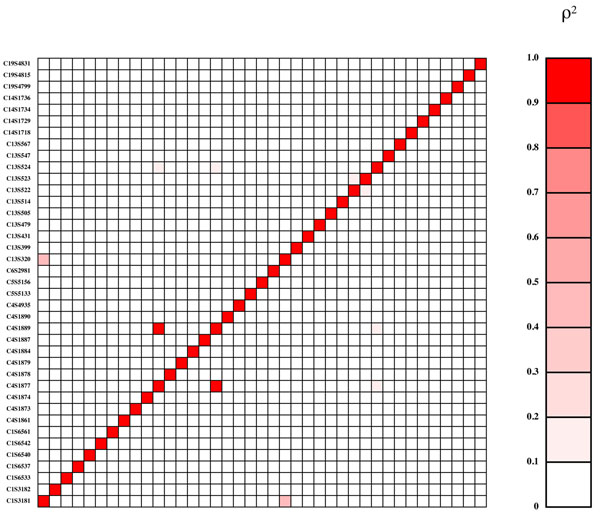
Gametic disequilibrium (r2) between functional variants for Q1. Markers are shown in chromosomal order from bottom to top and from left to right and are symmetric across the diagonal.